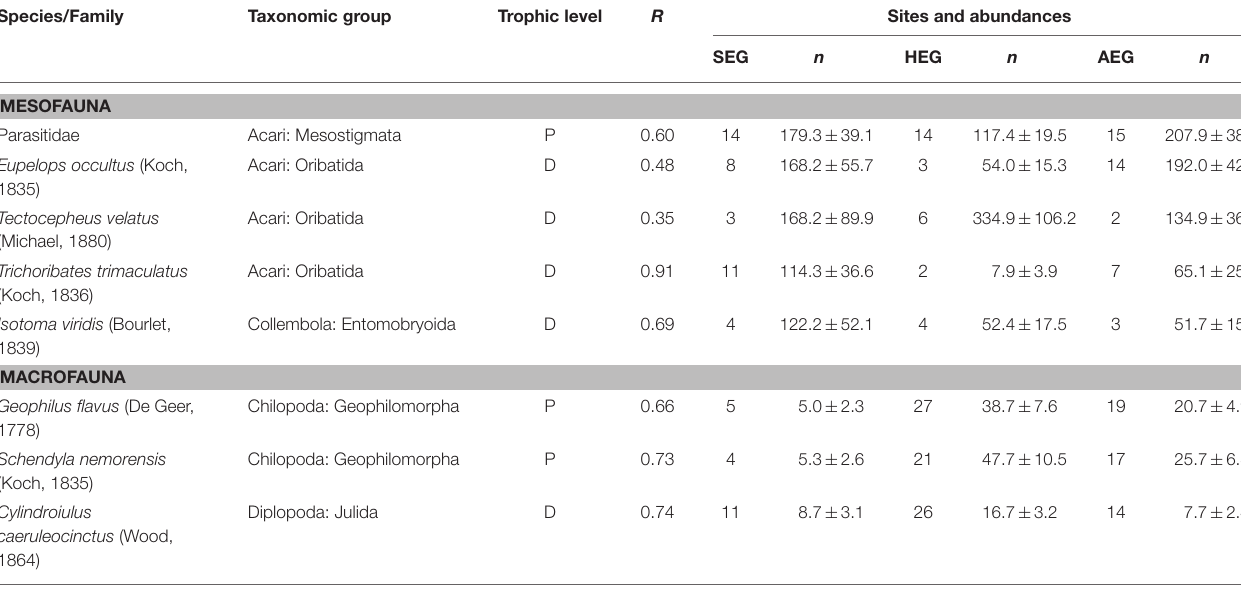
TABLE 1 | Soil arthropod taxa occurring in the grasslands of all three regions [SEG, Schorfheide-Chorin (northernmost); HEG, Hainich-Dün (central); AEG, Schwäbische Alb (southernmost)].